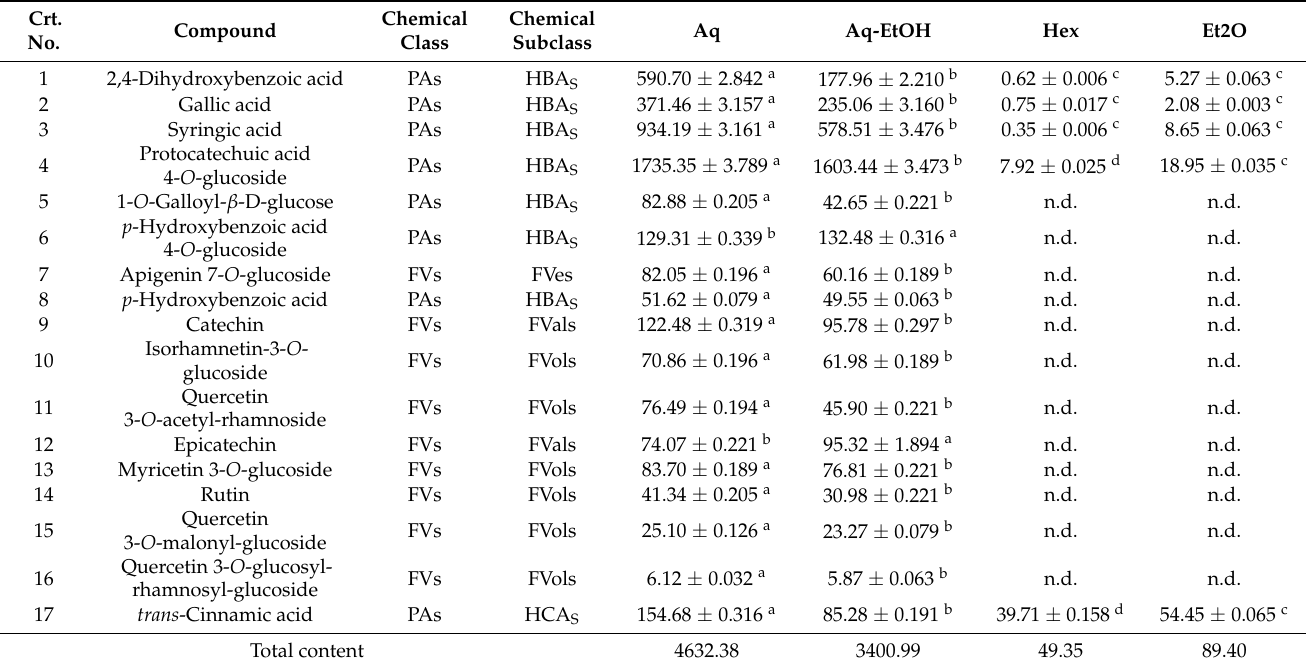
Table 3. Content of polyphenolic compounds ( µ g/g dw) in B. edulis extracts. Crt.